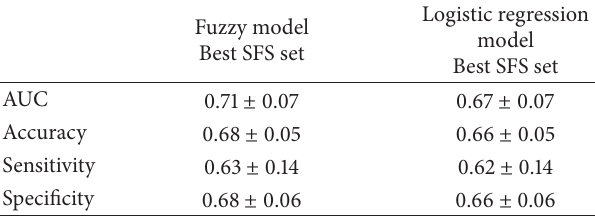
Table 3: Performance of the fuzzy and LR models within the first 6 hours after ICU admission using the best set of variables selected through sequential forward selection.